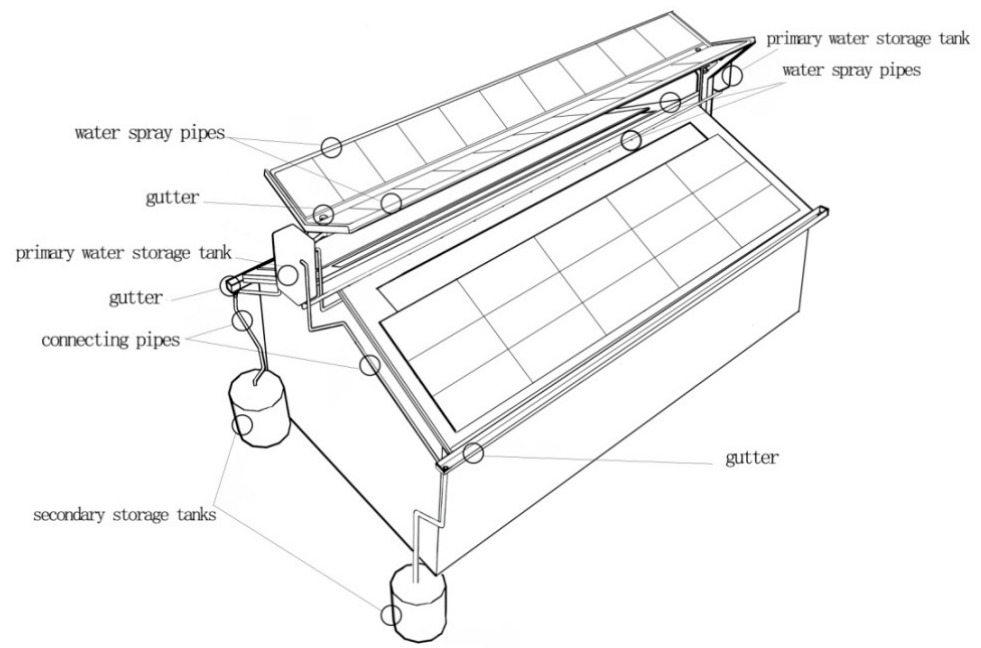
Figure 5. Rainwater harvester.